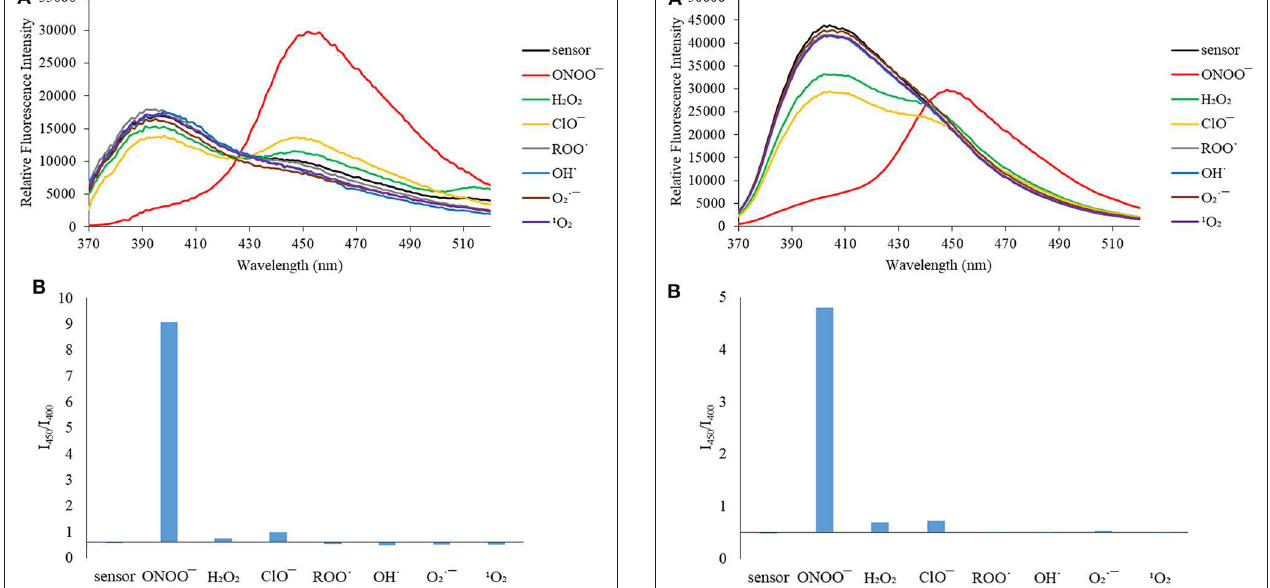
FIGURE 4 | (A) Selectivity data for CE (5 µ M): emission spectrum in the presence of ONOO − (50 µ M), OH · (500 µ M), O ·− 2 (500 µ M), 1 O 2 (500 µ M) after 5min. H 2 O 2 (1mM), ROO · (500 µ M) and ClO − (500 µ M) were measured after 30min. The data was obtained in PBS buffer, pH = 7.4 at 25 ◦ C at λ ex = 340 (bandwith: 20) nm on a BMG Labtech CLARIOstar ® plate reader. (B) Selectivity data for CE (5 µ M): relative intensity ratio in the presence of ONOO − (50 µ M), OH · (500 µ M), O ·− 2 (500 µ M), 1 O 2 (500 µ M) after 5min. H 2 O 2 (1mM), ROO (500 µ M) and ClO − (500 µ M) were measured after 30min. The data was obtained in PBS buffer, pH = 7.4 at 25 ◦ C at λ ex = 340 (bandwith: 20) nm on a BMG Labtech CLARIOstar ® plate reader.